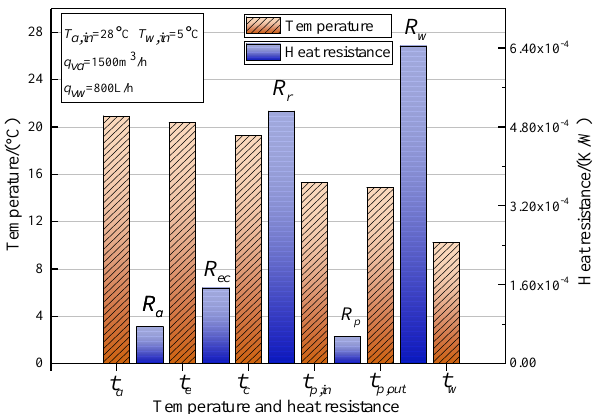
Figure 17. Distribution of temperature and heat resistance ( T w,in = 5 °C).